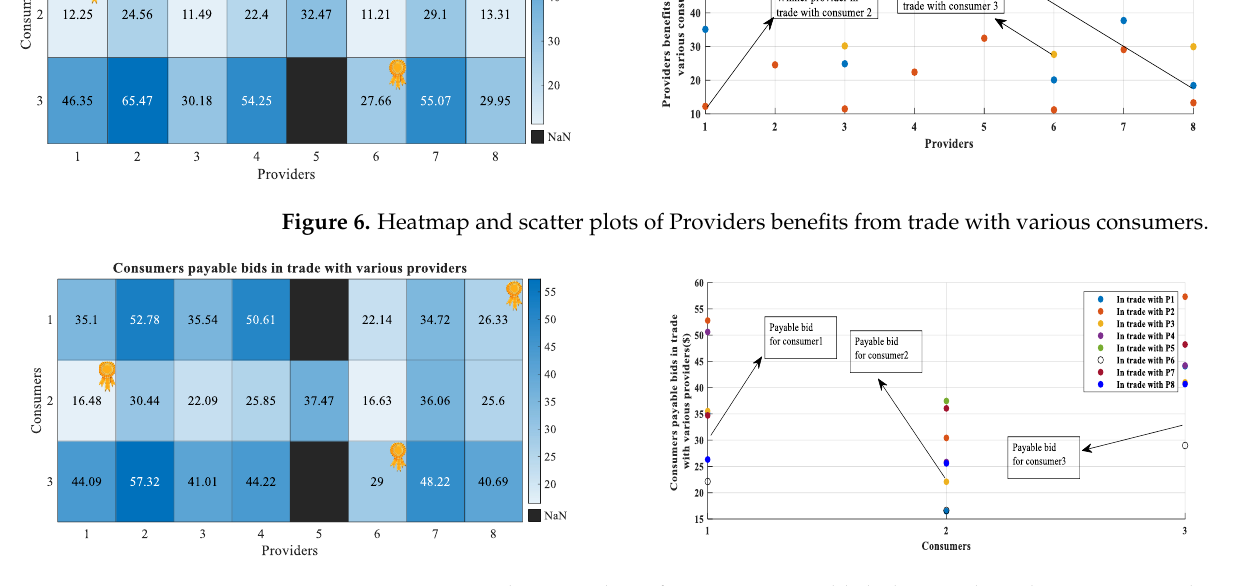
Figure 7. Heatmap and scatter plots of consumers payable bids in trade with various providers.